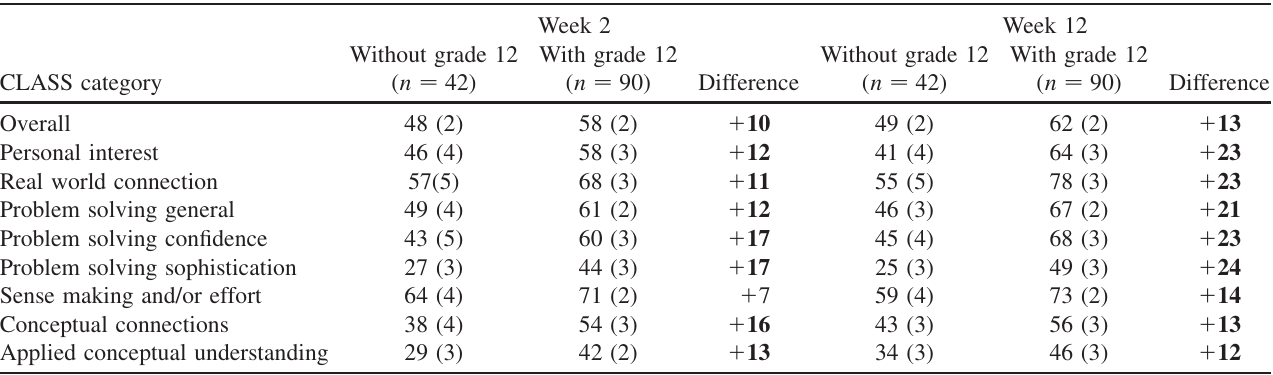
TABLE II. Relationship between taking grade 12 physics and favorable attitudes about physics in week 2 and week 12. Average percentage of favorable responses (agree with experts) is shown, with the standard error of the mean in parentheses. Differences that are statistically significant at the p < 0 : 05 level are shown in